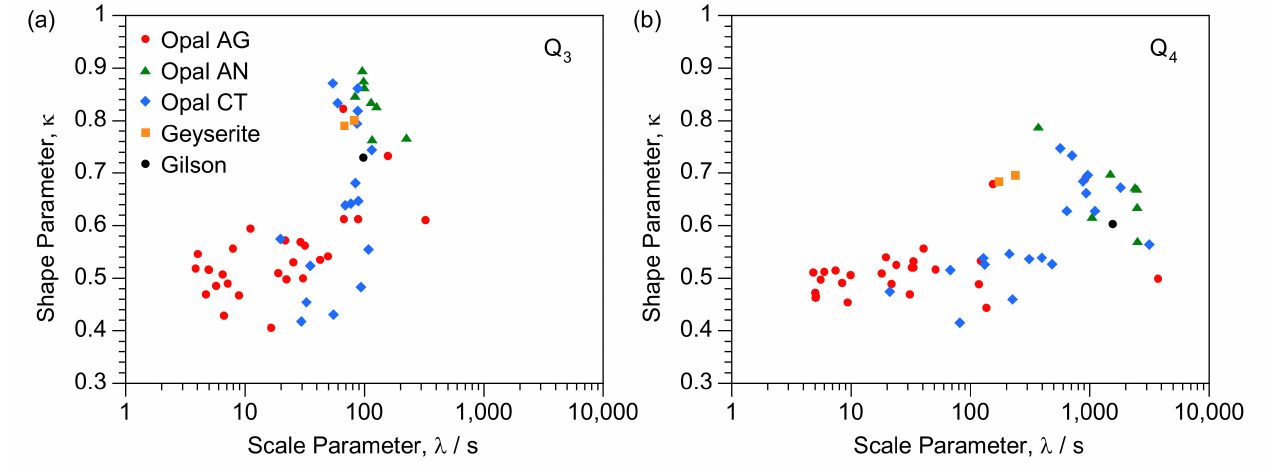
Figure 4. Correlation of consolidated scale and shape parameters for ( a ) Q 3 and ( b ) Q 4 and designated with opal